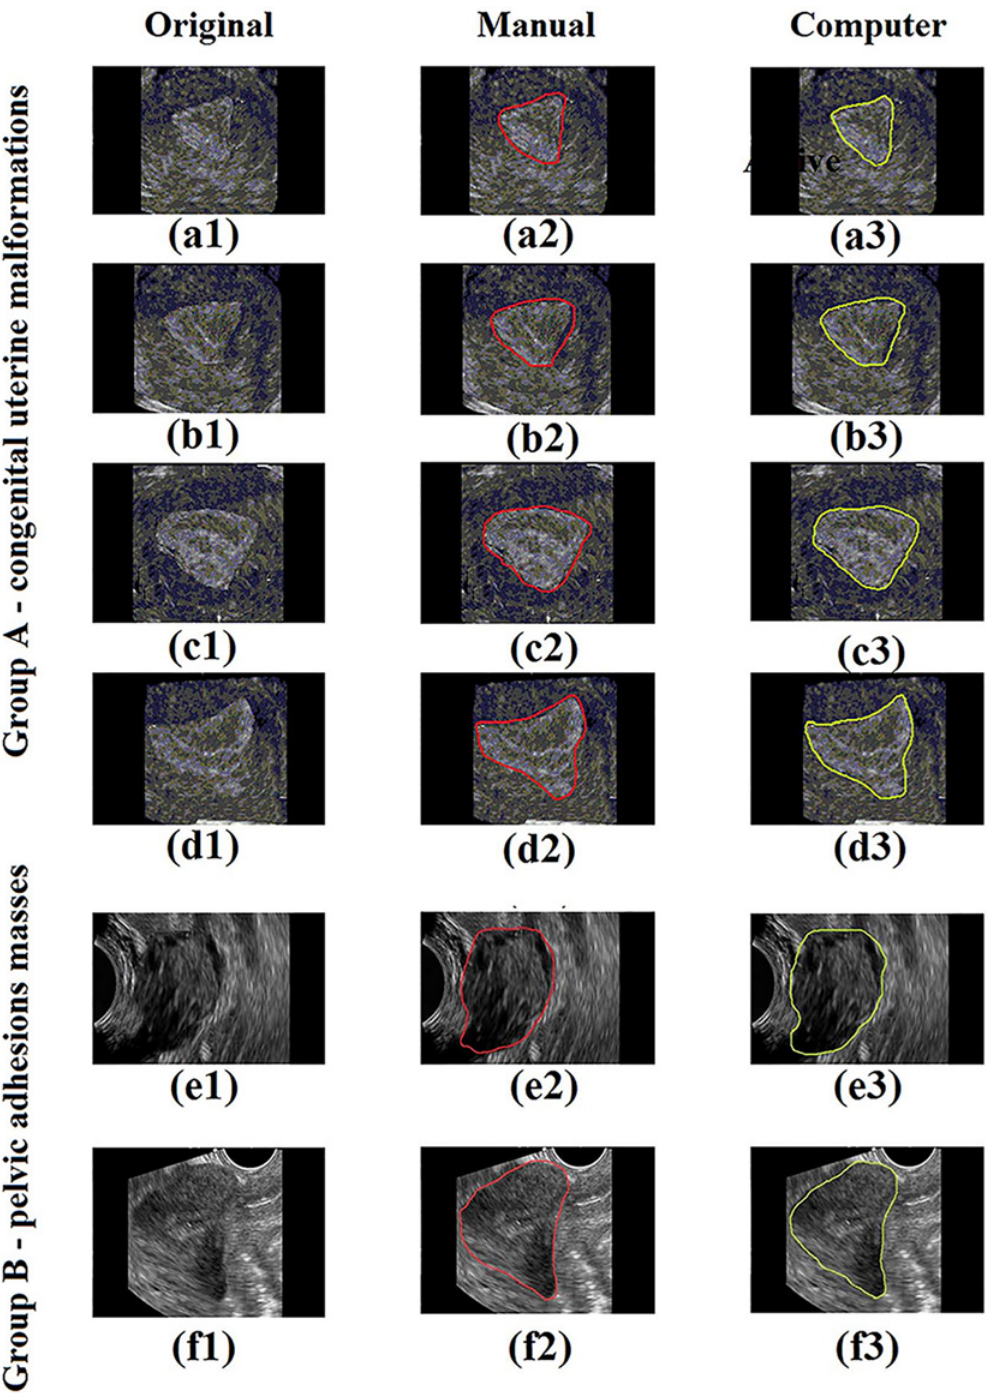
Fig 3. Gynecology ultrasound scans with segmentation of uterus by active contour model. (a1), (b1), (c1), (d1), (e1) and (f1) in the first column -are original images. (a2), (b2), (c2), (d2), (e2) and (f2) in the second column are images with uterus edge drawn by the doctor. (a3), (b3), (c3), (d3), (e3) and (f3) are images with uterus edge detected by our method. (a) to (d) represents Group A, and (e) to (f) represents Group B of our experiment.